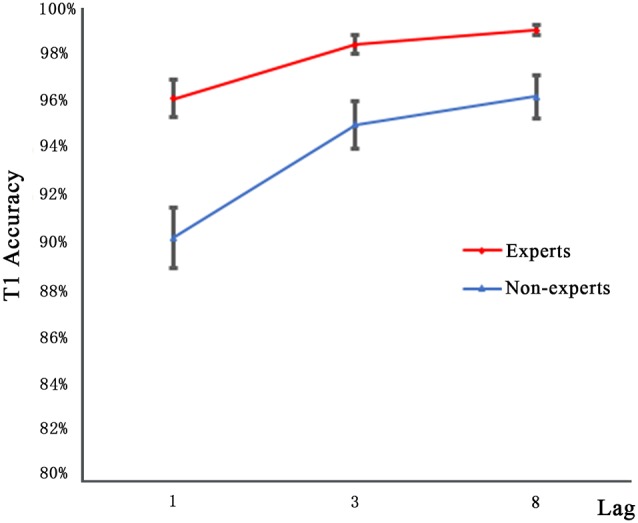
Mean accuracy for identifying T1 in the three lag conditions of experts and non-experts. Error bars stand for SE.